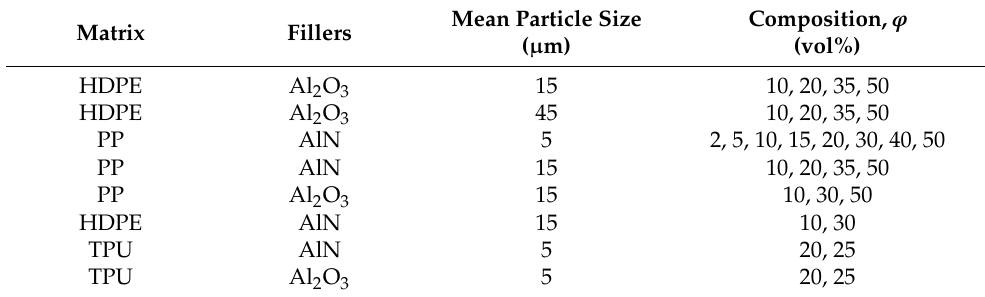
Table 2. Description of prepared polymer composite